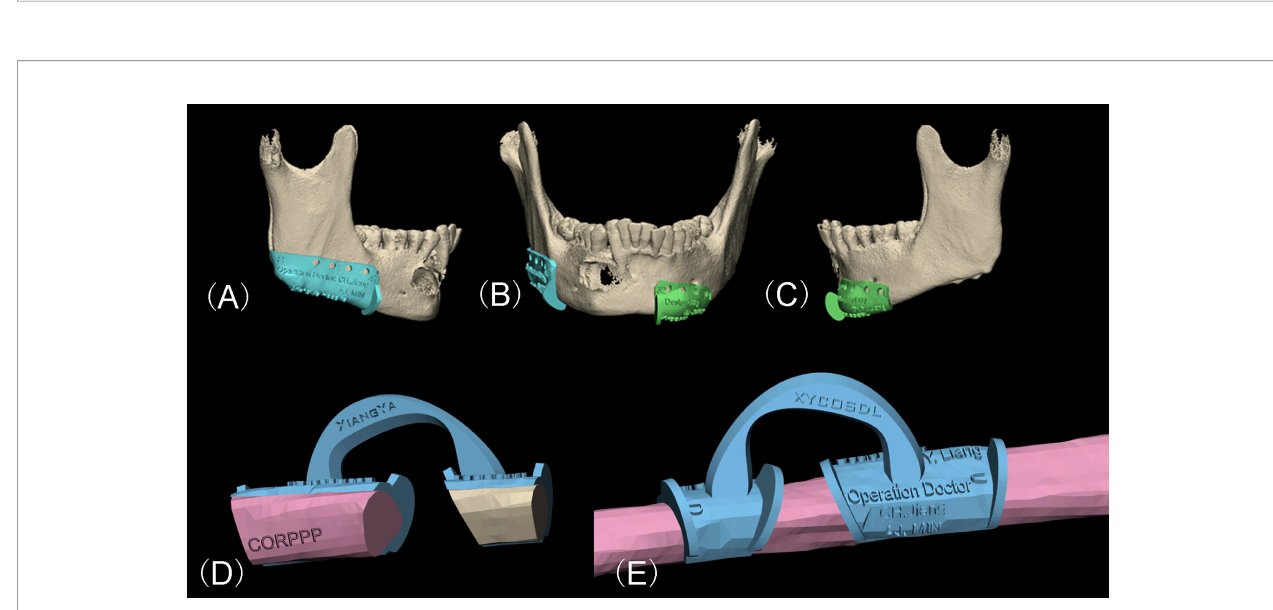
FIGURE 3 | Virtual design of the CORPPP guiding template. (A – C) Lateral and frontal view of placement of CORPPP mandibulectomy guiding templates with guiding wings and designed fi xing holes. (D, E) Medial and external view of the placement of CORPPP fi bular osteotomy templates.